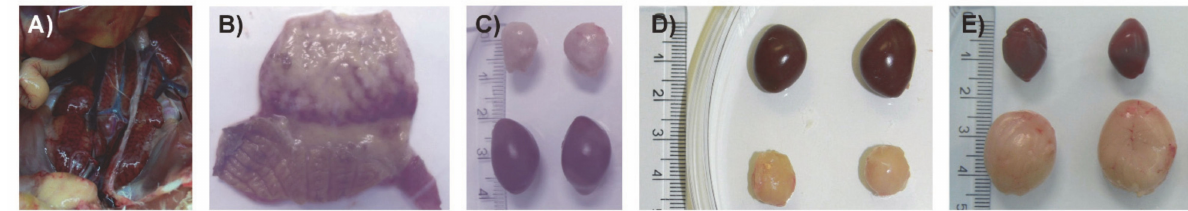
Figure 6. Pathological lesions observed at necropsy in SPF chickens inoculated with the re-assortant strains (Bug/03/Poland/2003 and 117/14/Poland/2014). ( A ) Kidneys from a bird inoculated with Bug/03/Poland/2003 that died at 3 dpi. ( B ) Proventriculus from a bird that died at 5 dpi inoculated with 117/14/Poland/2014. ( C – E ) Bursae and spleens from birds euthanized at 10 dpi inoculated with Bug/03/Poland/2003 ( C ), 117/14/Poland/2014 ( D ), and from the normal control ( E